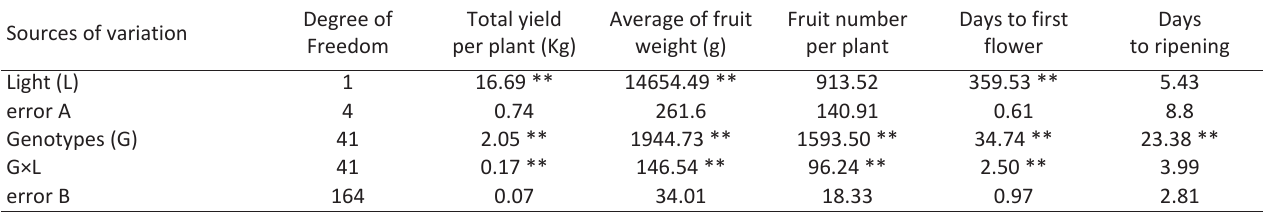
** Significant at P<0.01